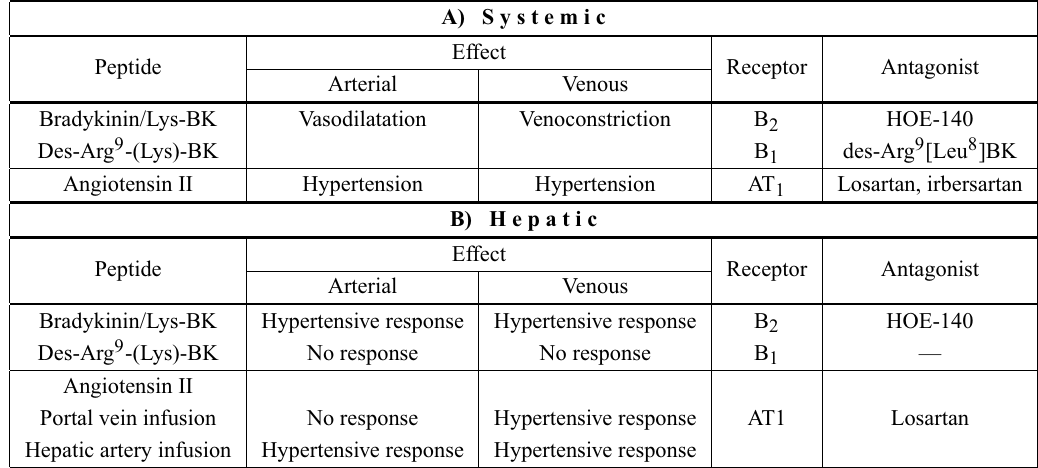
Vasoactive peptides: action and